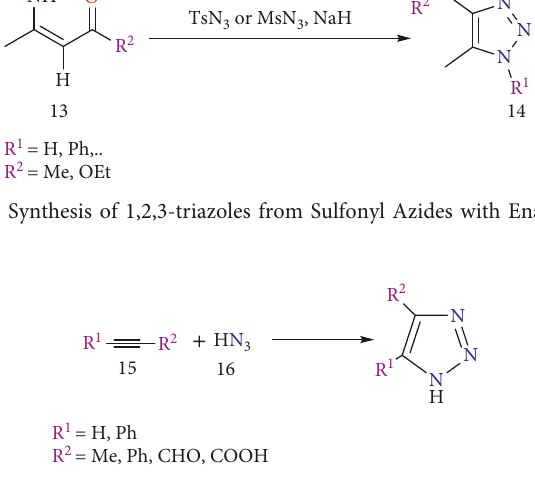
Scheme 9: Synthesis of 1,2,3-triazoles from Azides and Alkynes.